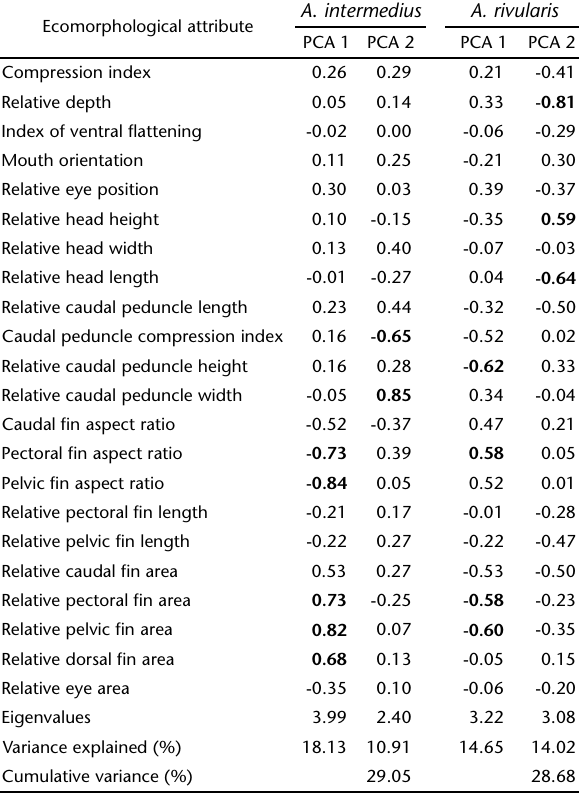
Table II. Contribution of ecomorphological attributes to the first two axes of the principal component analysis for Astyanax intermedius and Astyanax rivularis collected in Rio São Francisco streams in September